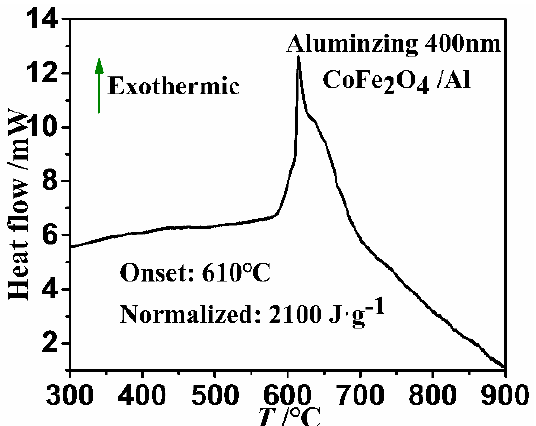
Figure 5. The differential scanning calorimetry (DSC) curve of the CoFe 2 O 4 /Al NWs nanothermite film (Al = 400 nm). Table 1. Comparisons of exothermic performances of the CoFe 2 O 4 /Al, Fe 2 O 3 /Al and Co 3 O 4 /Al.